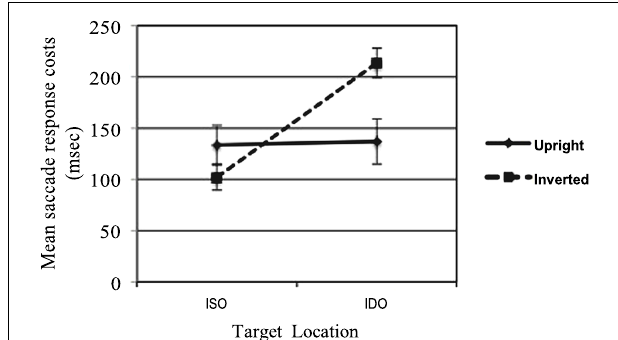
FIGURE 6 | Infants’ means saccade response costs from invalid cueing trials (given by invalid-cue latencies minus valid-cue latencies) related to the two invalid conditions (i.e., whether the stimuli that contained the target was cued or uncued) and the two types of stimuli presented (upright and inverted faces).